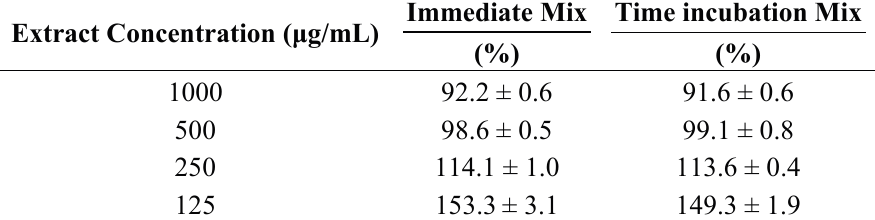
Table 2. Percent corrections for APTT 1:1 mixing studies of different concentrations of Subfraction B on standard human normal pooled plasmas. Subfraction B as active anticoagulant fraction was purified through a series of bioassay-guided fractionation. Values are mean ± S.E.M. ( n =